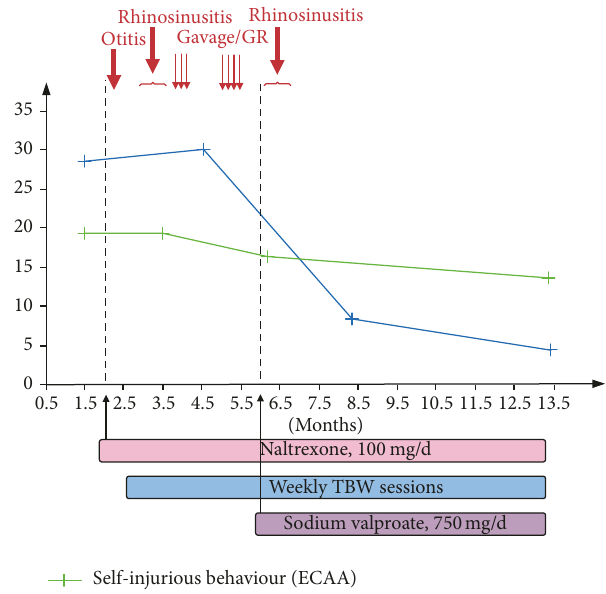
of eyeballs (Figure 2). Echocardiography and abdominal